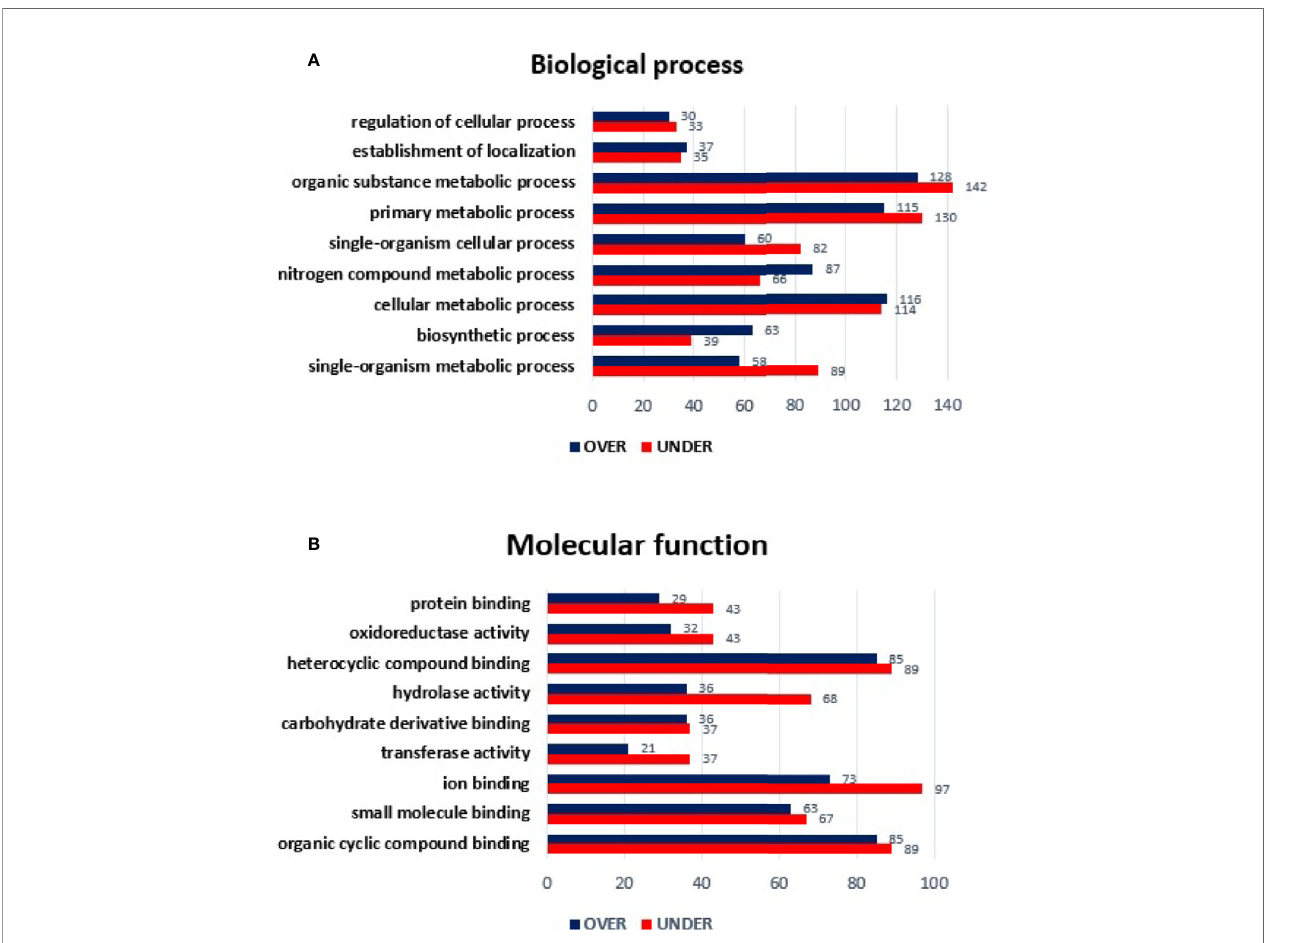
FIGURE 4 | Gene ontology of differentially represented proteins from salivary glands of R. sanguineus tropical lineage vs. R. sanguineus temperate lineage in the infection condition. GO terms and its representation of biological process (A) , and molecular function (B) obtained using level 3. Blue bars represent the number of over-represented proteins in the tropical lineage compared to the temperate lineage and red bars represented the number of under-represented proteins in the tropical lineage compared to the temperate lineage (can be interpreted as the number of proteins more represented in the temperate lineage compared to the tropical lineage), with statistical signi fi cance ( p <